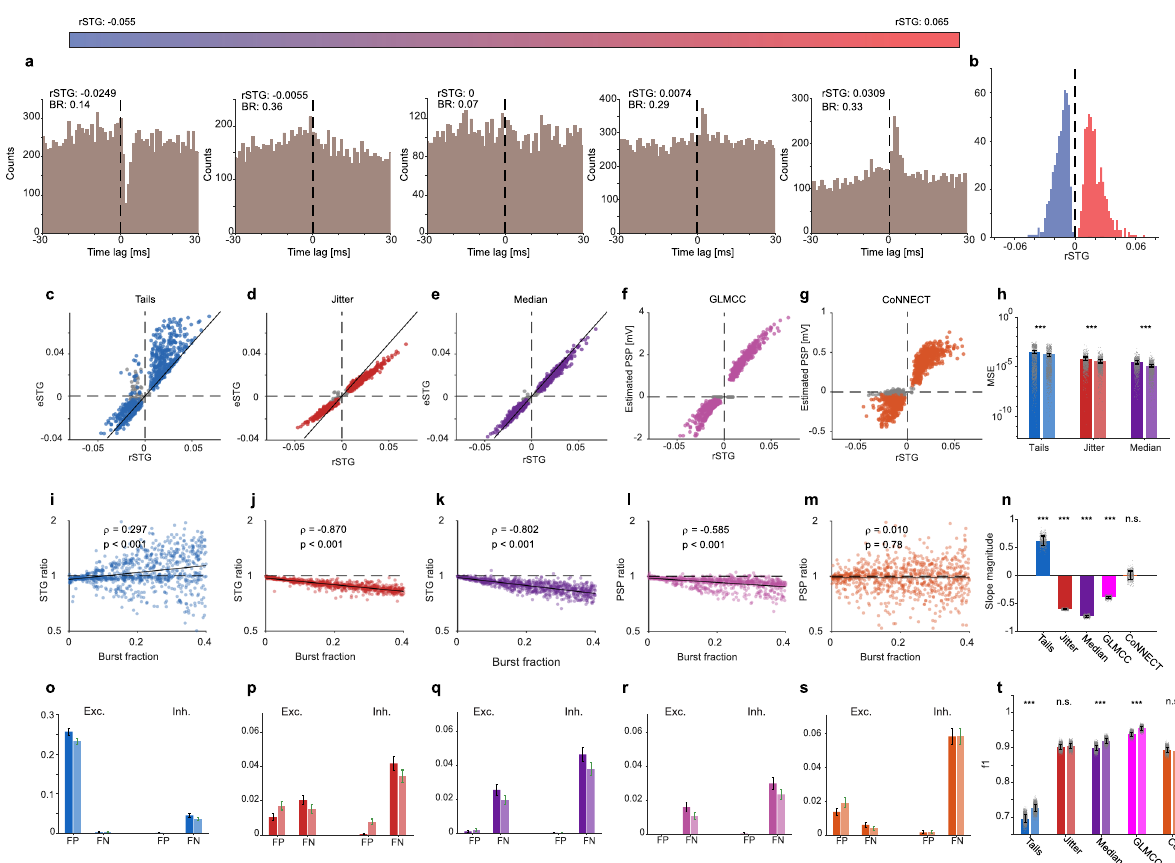
Fig. 4 Deconvolution improves quanti fi cation and detection of inter-neuronal connections. a , b A thousand pairs of neurons with monosynaptic connections and 250 unconnected pairs were simulated. Connectivity strengths (rSTG), burst fractions, co-modulation, and recording durations were varied between pairs. a Example CCHs from the noisy point process simulations, sorted by rSTG values. BR, burst fraction. b Empirical distribution of the n = 500 excitatory (red) and n = 500 inhibitory (blue) rSTGs of the pairs used in the simulations. c – g STGs or PSPs are plotted against the ground truth (rSTG) for dcCCHs ( n = 1000 connected pairs), estimated using the tails ( c ), jitter ( d ), median ( e ), GLMCC ( f ), and CoNNECT ( g ) methods. Colored (or gray) dots depict estimated STGs or PSPs which were (or were not) detected as connections. In all methods (except CoNNECT), the signi fi cance threshold used was α = 0.001. In ( c – e ), solid black lines represent perfect estimation (i.e., eSTG = rSTG). h Mean square errors (MSE) for the STG-based methods, in which the ground truth and the estimates have the same units. Error bars, SEM. Deconvolution reduces the MSE for all STG-based methods ( n = 1000 connected pairs; *** p < 0.001, Wilcoxon ’ s paired signed-rank test). The smallest errors are obtained for median fi ltering with deconvolution. i – m STG ( i – k ; or PSP, l , m ) ratio as a function of burst fraction. STG ratio is de fi ned as the STG estimated from the CCH, divided by the STG estimated from the dcCCH. The PSP ratio is de fi ned in an analogous manner. For all methods except CoNNECT, deconvolution reduces the effect of burstiness. n Slope of best linear fi t, computed for ( i – m ) ( n = 1000 connected pairs; n.s./*** p > 0.05/ p < 0.001, bootstrap test, n = 300 iterations). o – t Effect of deconvolution on detection. o – s False-positive (FP) and false-negative (FN) rates were computed for excitatory (Exc.) and inhibitory (Inh.) connections, using CCHs (dark bars) and dcCCHs (light bars). Fractions are out of a population of {Exc. FP: n = 2000; Exc. FN: n = 500; Inh. FP: n = 2000; Inh. FN: n = 500} connections. t Mean f 1 scores for all connections, with and without deconvolution. Error bars, SEM. Deconvolution improves detection performance for the tails, median, and GLMCC methods (n.s./*** p > 0.05/ p < 0.001, bootstrap test, n = 3500